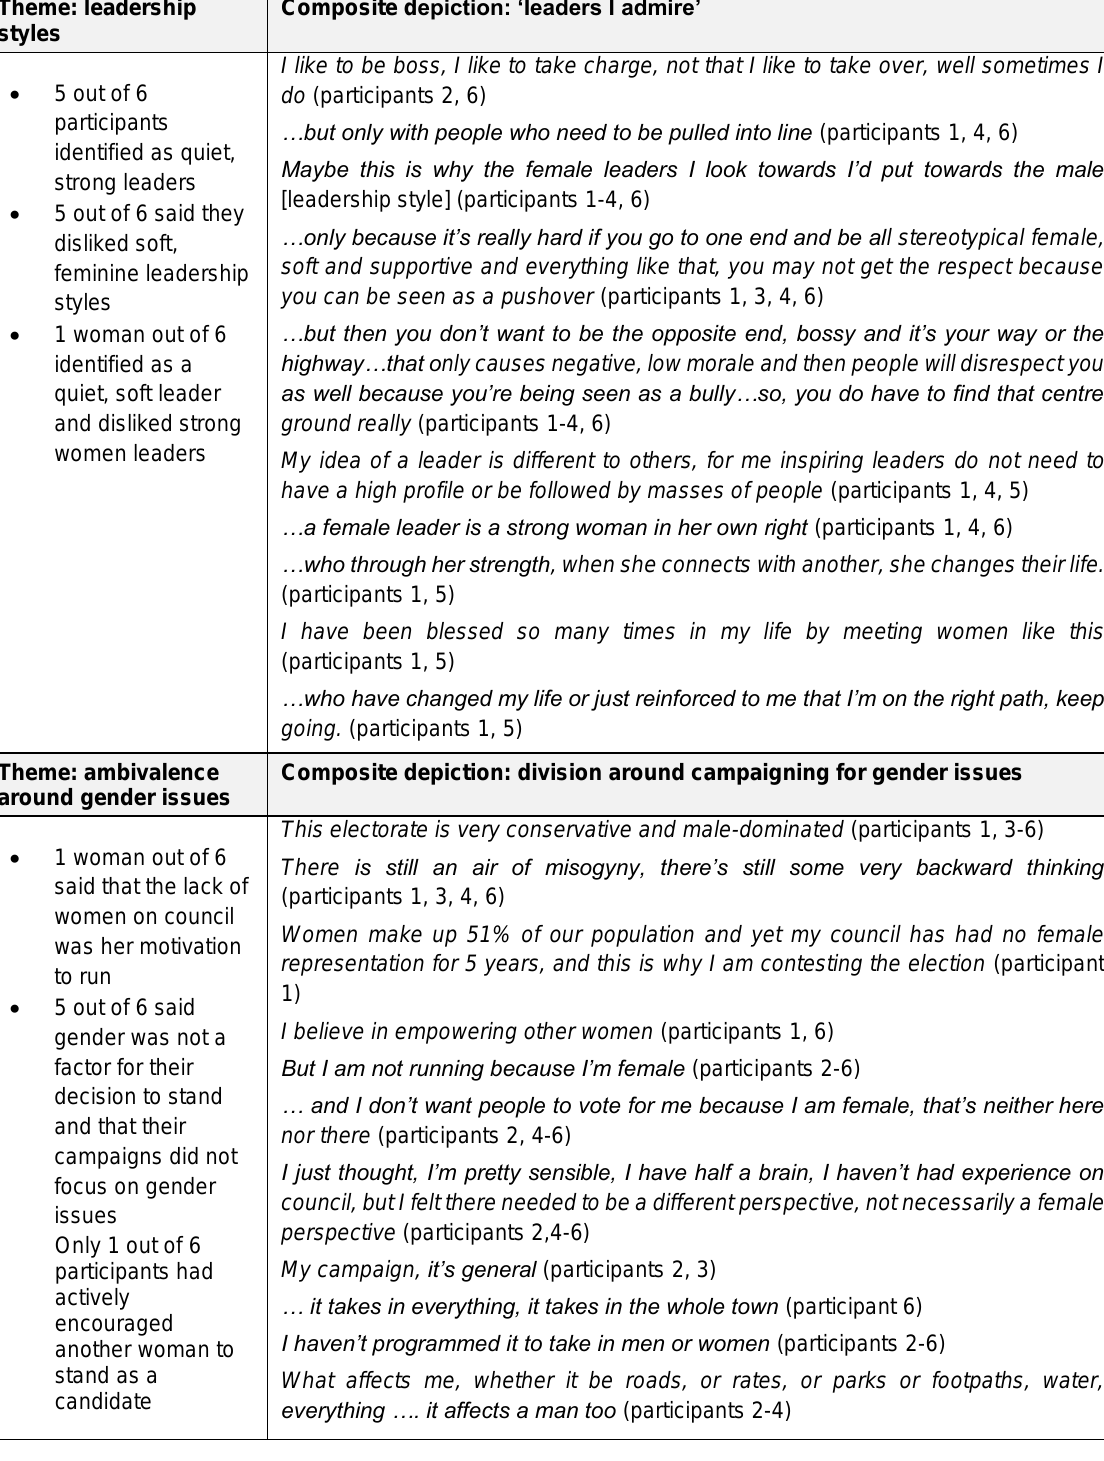
Table 1: Key themes of women seeking election to local government